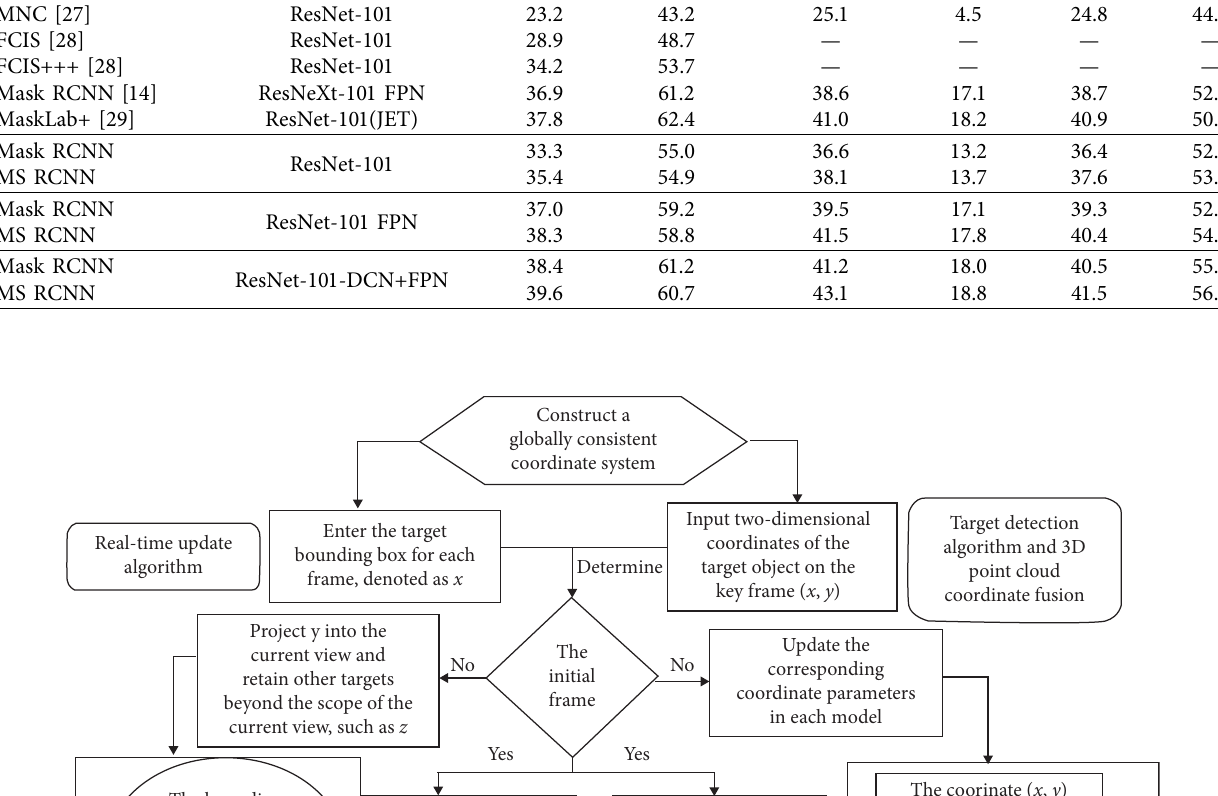
Table 1: Comparative results of MS RCNN algorithm and other instance segment algorithms on COCO testing set. Method